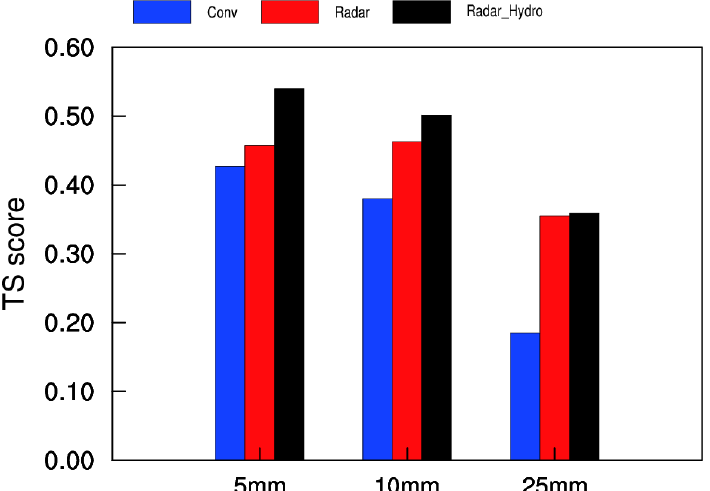
Figure 11. TS score of 3 h accumulated precipitation from 0600 UTC, 13 September to 0900 UTC, 13 September. 13